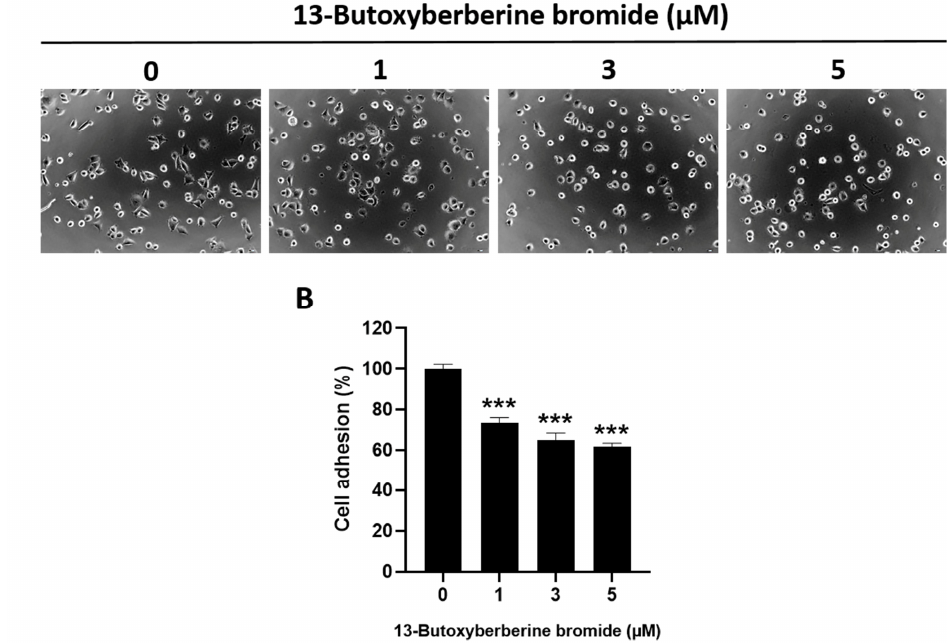
Figure 5. Inhibitory effect of 13-butoxyberberine bromide on cell adhesion in A431 cells. ( A ) Morphology of A431 cells after treatment with 13-butoxyberberine bromide cultured in Matrigel-coated plate (200 × magnification). ( B ) The histogram shows percentage of cell adhesion after incubation with 13-butoxyberberine bromide. Data were expressed as mean ± SD ( n = 3). *** p < 0.001; significant difference from the control group.